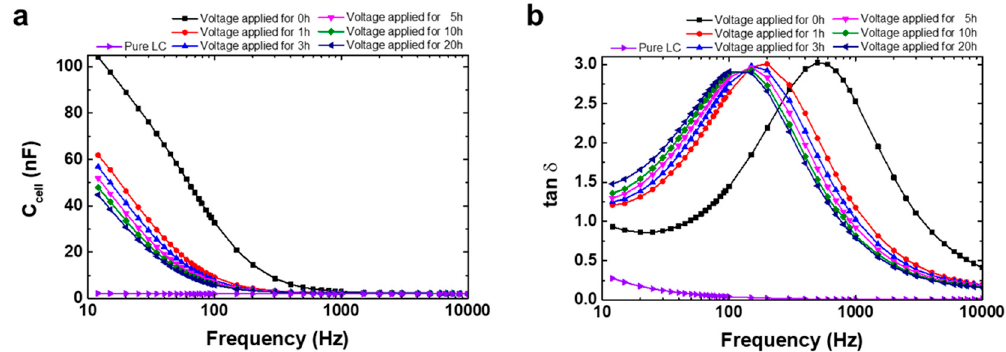
Figure 8. Frequency dependence of the measured ( a ) capacitance and ( b ) dielectric loss tangent for the ion-doped LC cell as a function of time and that of the pure LC cell.